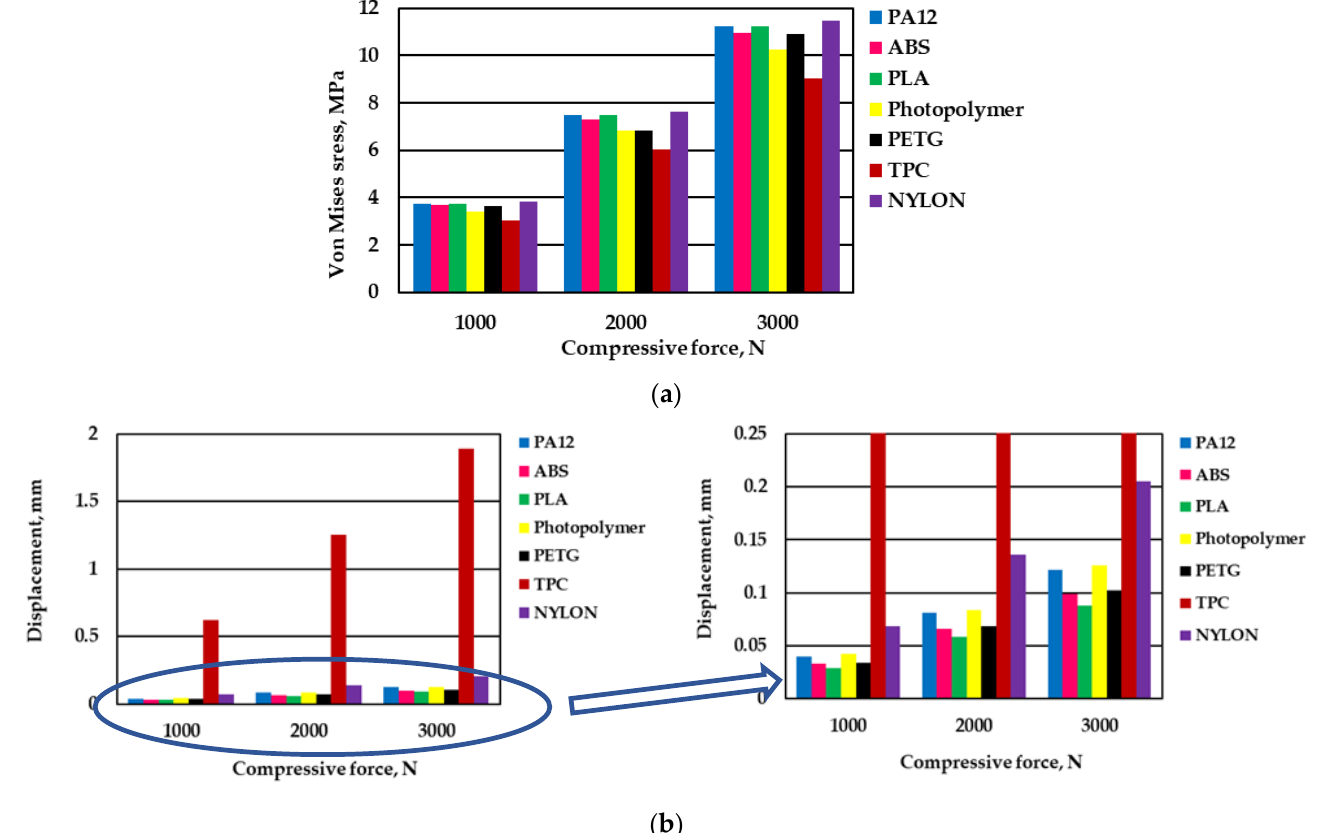
Figure 7. The comparison of results of the static analysis of heels from various materials: ( a ) von Mises stress, MPa; ( b ) displacement, mm.